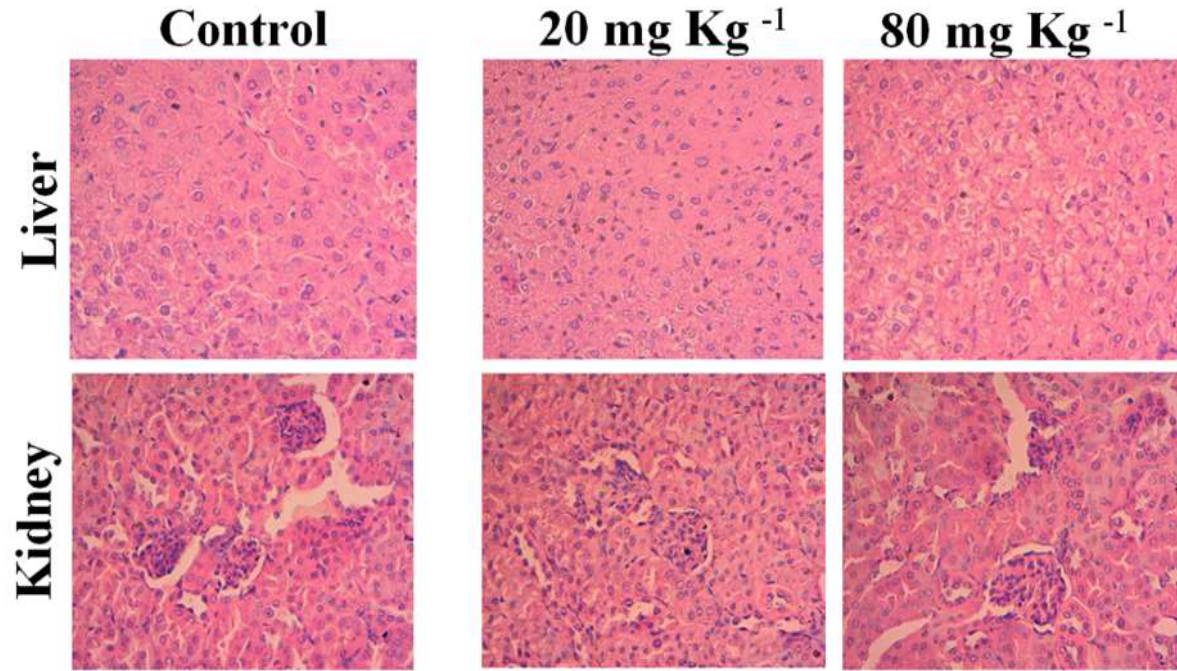
Figure 7: Histological images for liver and kidney of mice administrated the RES-loaded poloxamer 407 by intraperitoneal injection with two different doses (20, and 80 mg Kg −1 ). Magnification of images is